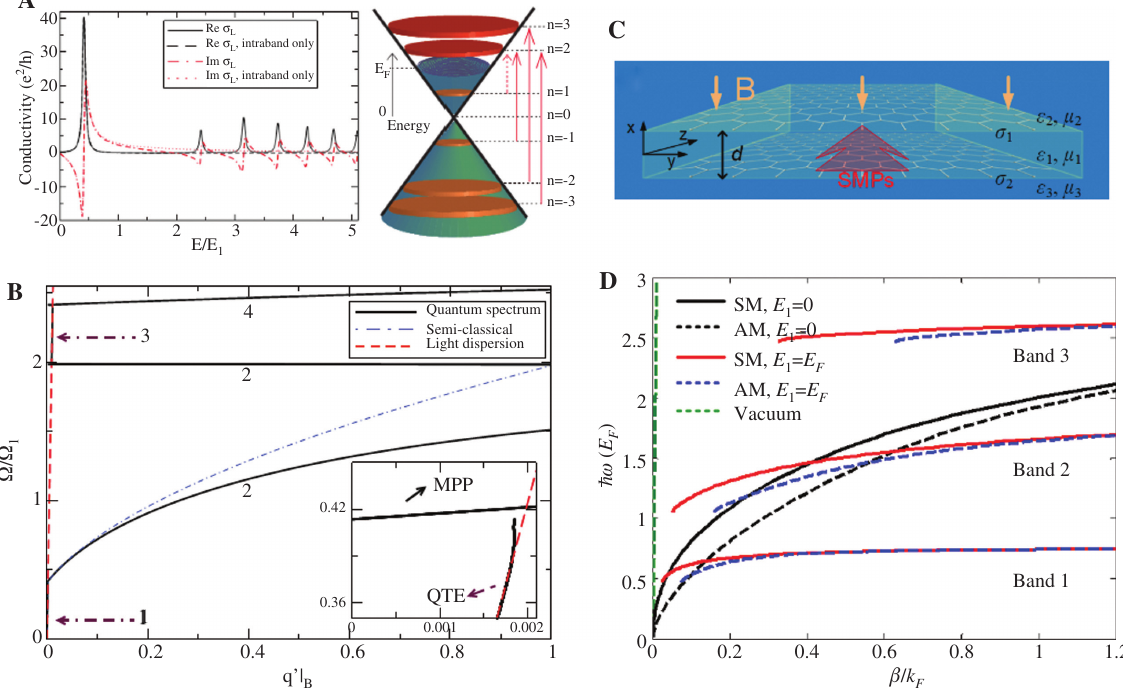
Figure 12: (A) Conductivity of doped graphene in a magnetic field (from [90], http://dx.doi.org/10.1103/PhysRevB.85.205426). (B) Disper- sion relation of SMPs on a single layer graphene (from [90]). (C) Schematic structure of SMPs propagating on a double layer graphene (from [91]). (D) Dispersion relation of SMPs on a double layer graphene (from